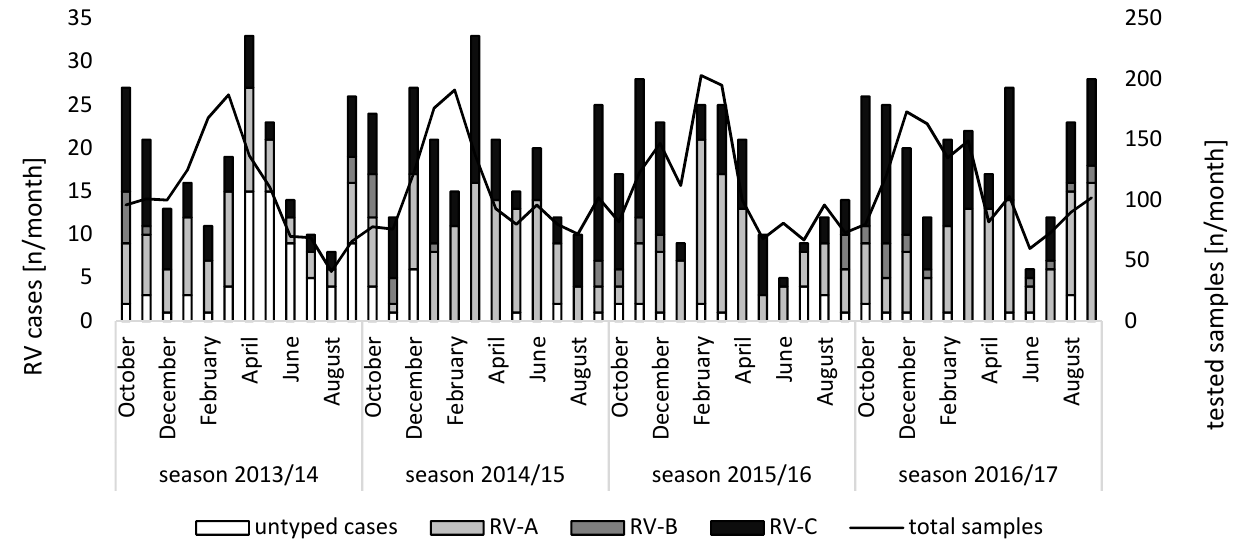
Figure 1. Monthly total numbers of tested samples and rhinovirus cases (n = 776) stratified by species A, B, and C, as well as untypable rhinoviruses. Note the two different y-axes: the left axis shows the absolute numbers of detected rhinovirus A, rhinovirus B, and rhinovirus C cases, as well as the absolute numbers of untyped cases, while the right axis shows the absolute number of tested samples. Table 1. Gender, age, and rhinovirus species distribution during the study period.